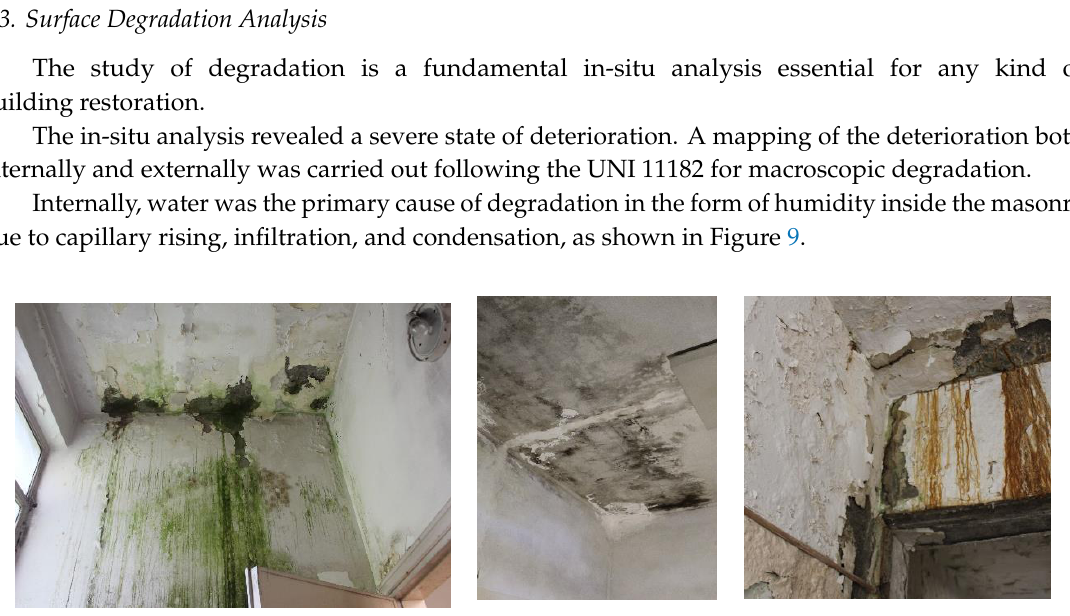
Figure 8. Examples of damage on structural elements.